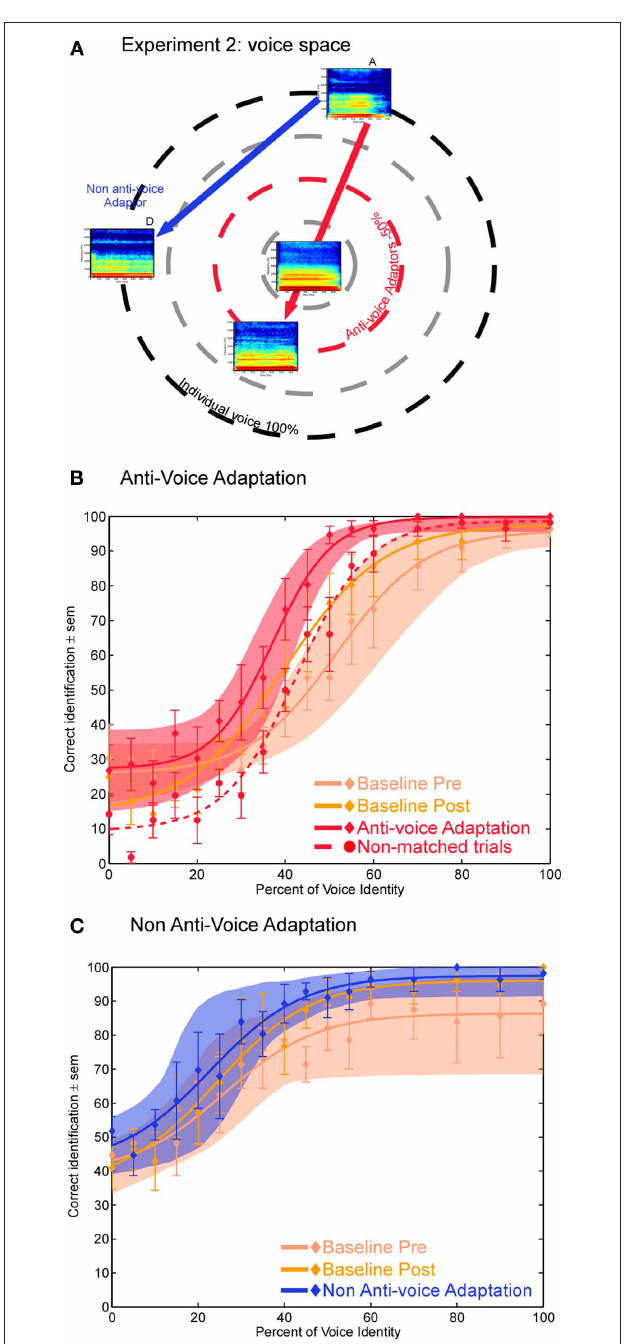
Figure 4 | experiment 2 (A) Position of an individual voice (voice A), its matched anti-voice adaptor (red circle) and a non-anti-voice adaptor (voice D) in theoretical voice space. (B,C) Identification performance after adaptation with (B) the anti-voice adaptors and (C) the voice D adaptor. Note the greater voice identity aftereffect for